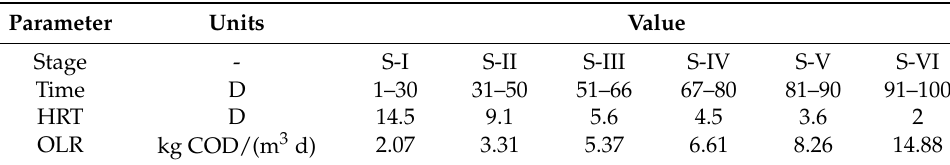
Table 1. AF and AFB operating modes.